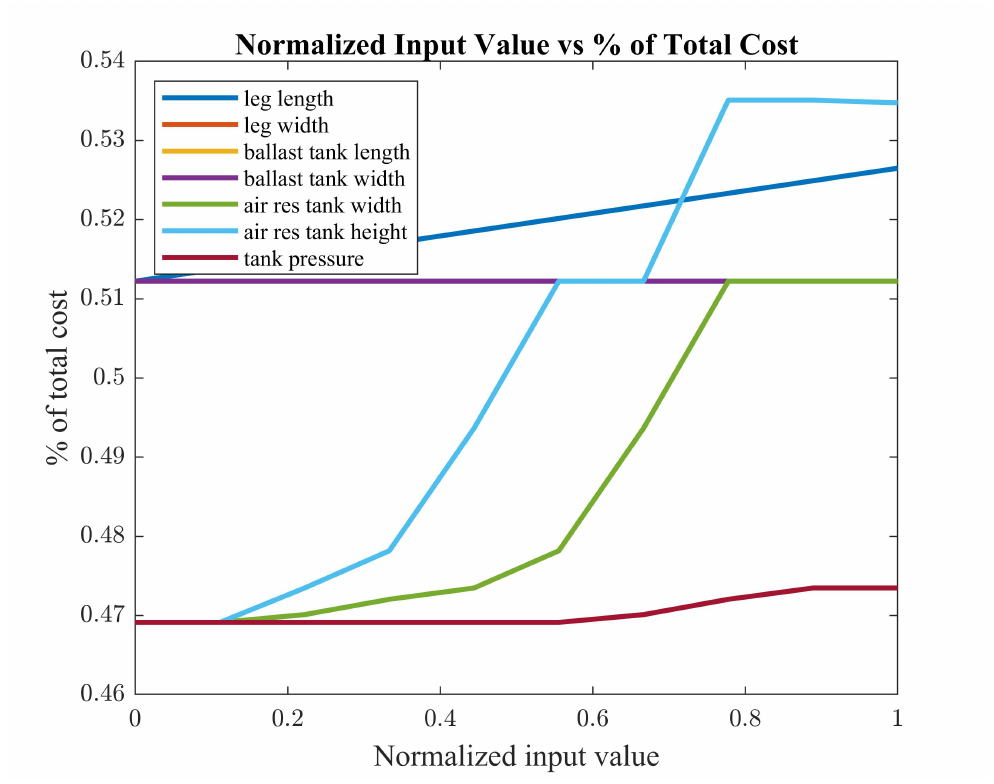
Figure 12. Graph of the percentage of the total system cost for each input